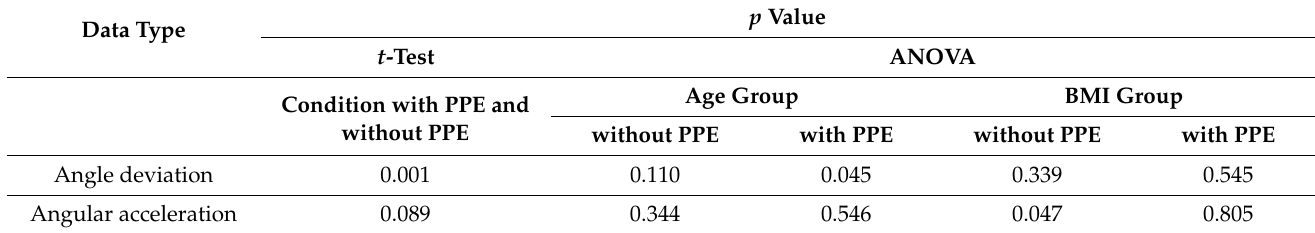
Table 2. Comparison statistical test.